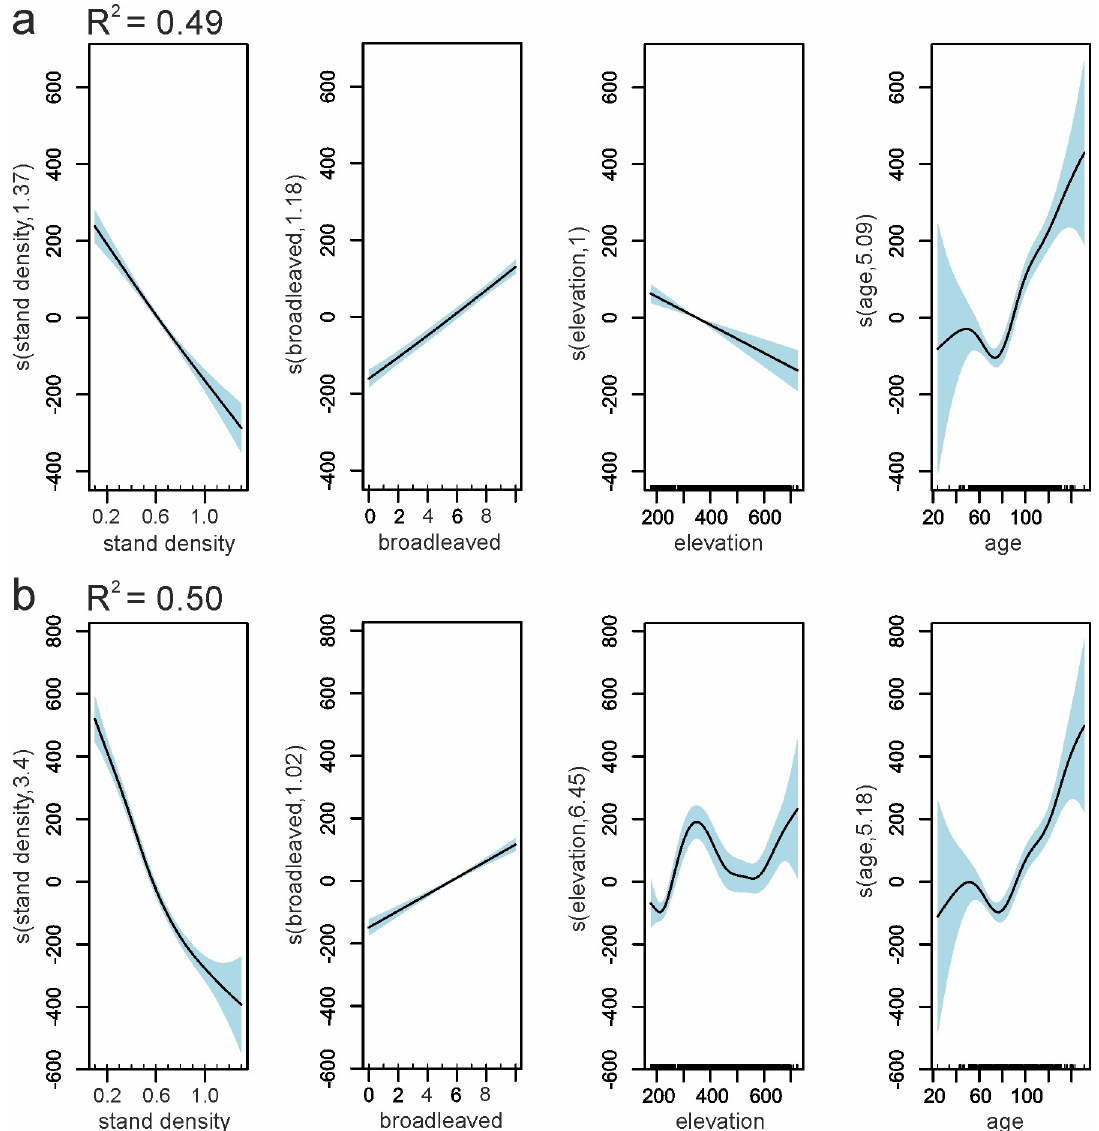
Fig 9. GAMs results–visualization of partial effects on Scots pine reflectance from predictors: a) NIR1 on July 1 st ; b) SWIR1 on April 20 th . The solid line represents the relationship between predictor and response variables, and the light blue shaded area represents confidence